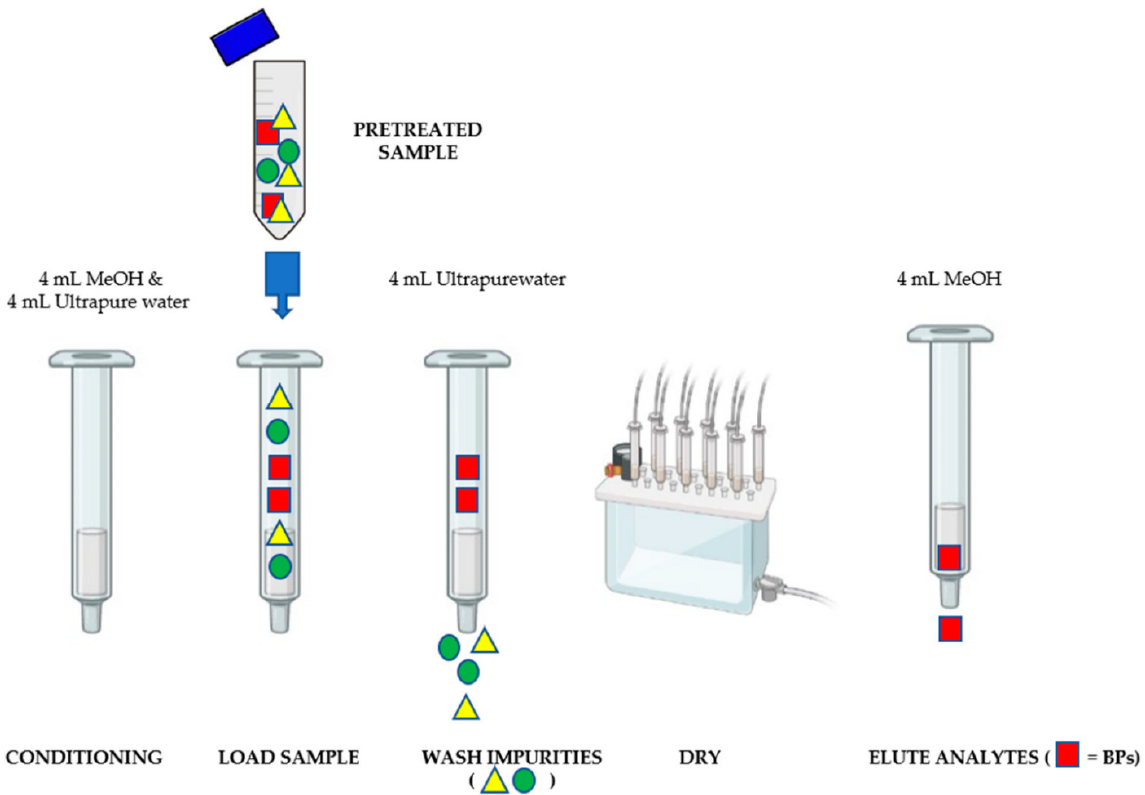
Figure 2. Illustrated scheme of the solid-phase extraction process.